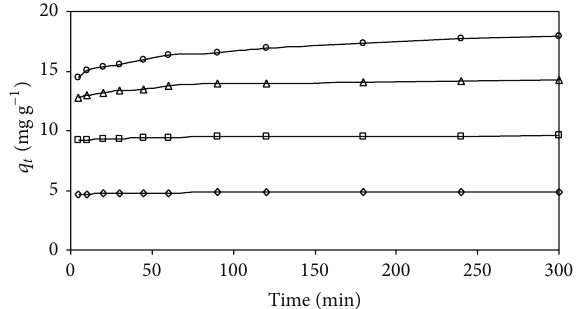
Figure 9: Pseudo-first-order model for AB25 on IJSP for different initial concentrations. Conditions as in Figure 8.